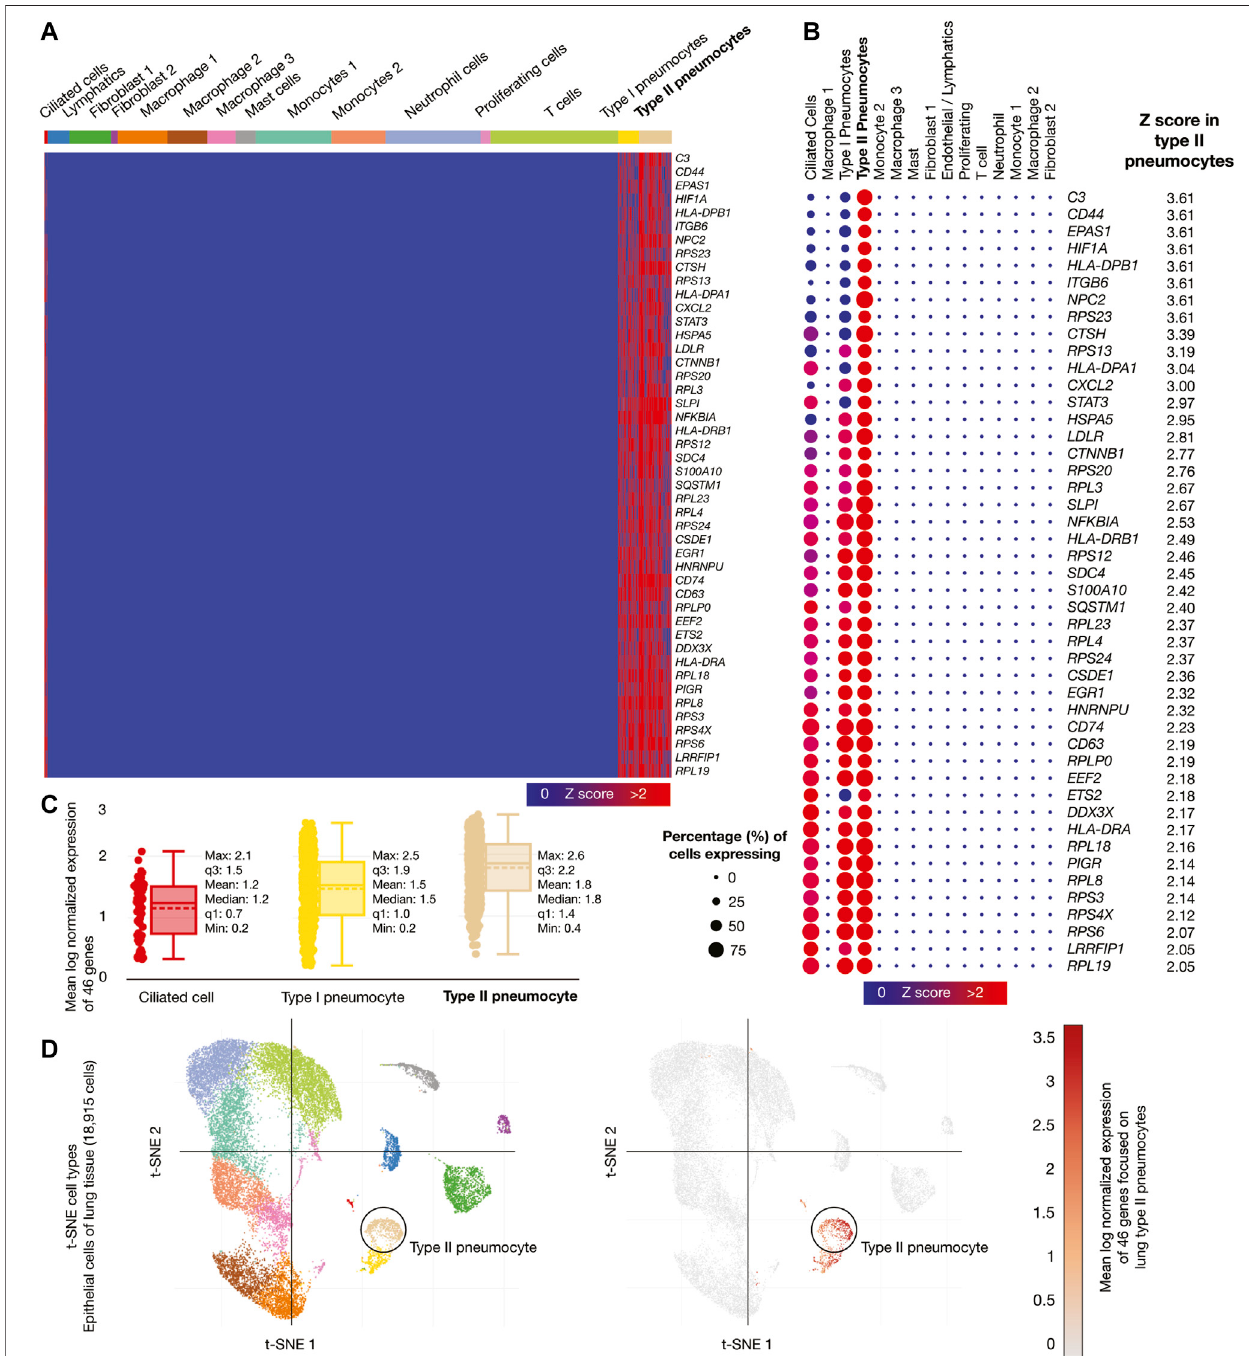
FIGURE5| Single-cell RNA-sequencingdata analysisofthehigh-con fi denceimmunesystemnodes inlung cells. (A) Heatmap ofsigni fi cantoverexpressed genes (Z-score > 2)inlungtypeIIpneumocytes. (B) Dotplotofsigni fi cantoverexpressedgenesinlungtypeIIpneumocytesandpercentageofcellsexpressing. (C) Boxplotsof lung cell types according to their mean log normalized expression. (D) t-distributed stochastic neighbor embedding cell type and mean log normalized expression focused on lung type II pneumocytes.